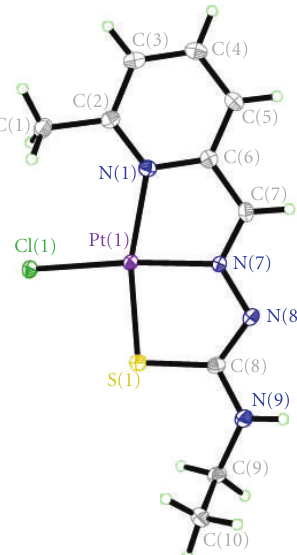
Figure 4: Structure of [Pt(mpETSC)Cl] with numbering scheme.